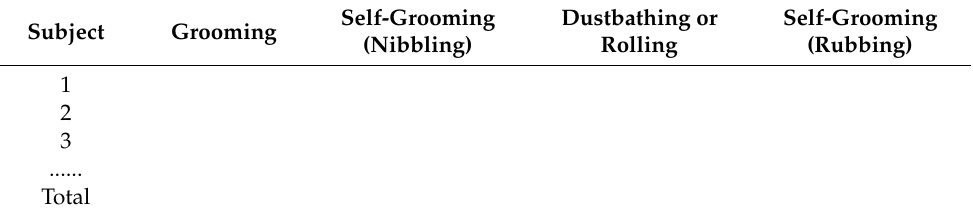
Table 3. Monitoring of donkey ethological indicators of welfare.